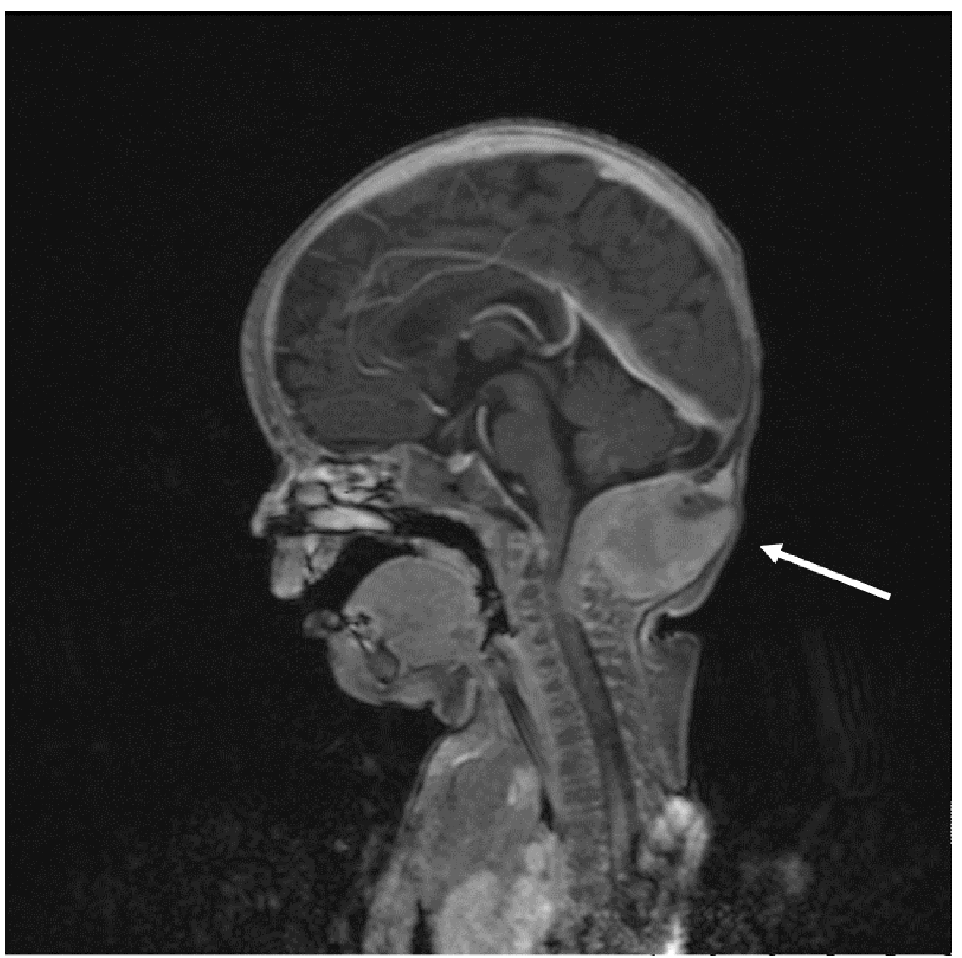
Figure 5. Patient 3: a sagittal T1-weighted MR scan shows large, suboccipital, mainly extracranial pathological solid mass compressing the spinal cord (C1–C3). Table 3. Chemotherapy in patient 3.